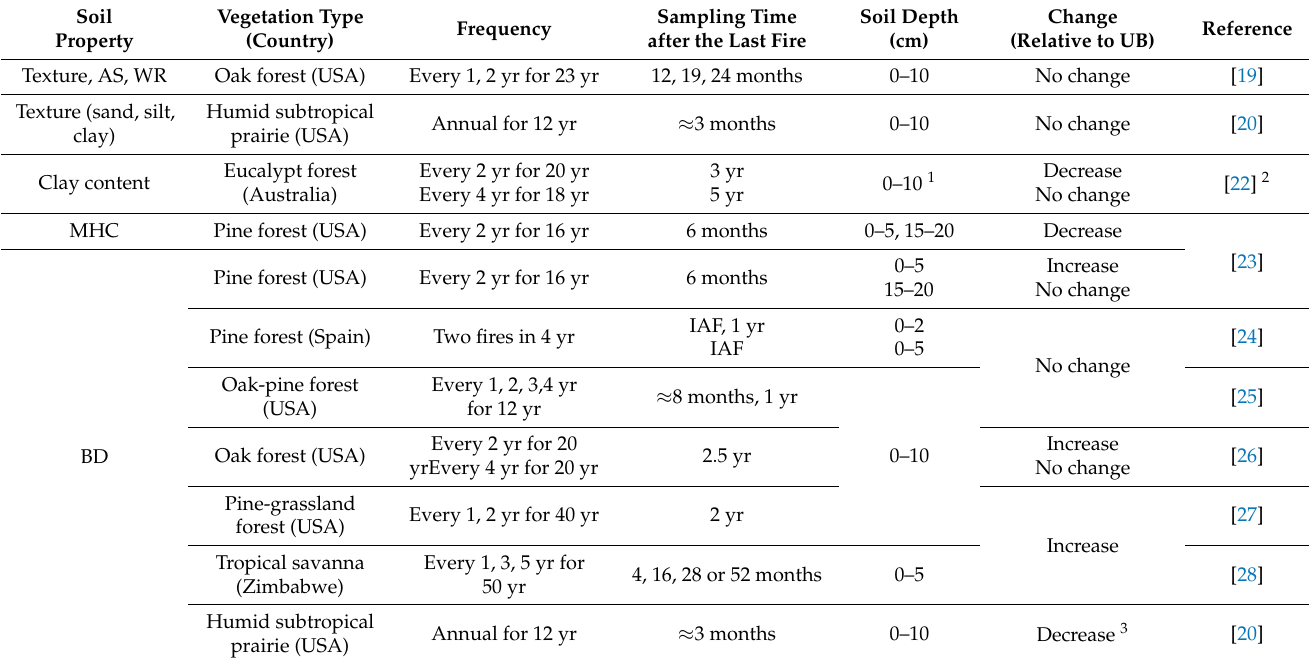
Table 1. Studies including the effects of repeated prescribed fires on soil physical properties: texture, aggregate stability (AS), water repellency (WR), moisture holding capacity (MHC) and bulk density (BD). UB: unburned soil; yr: year; IAF: immediately after